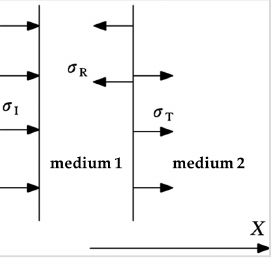
Figure 3. Incidence, reflection, and transmission.